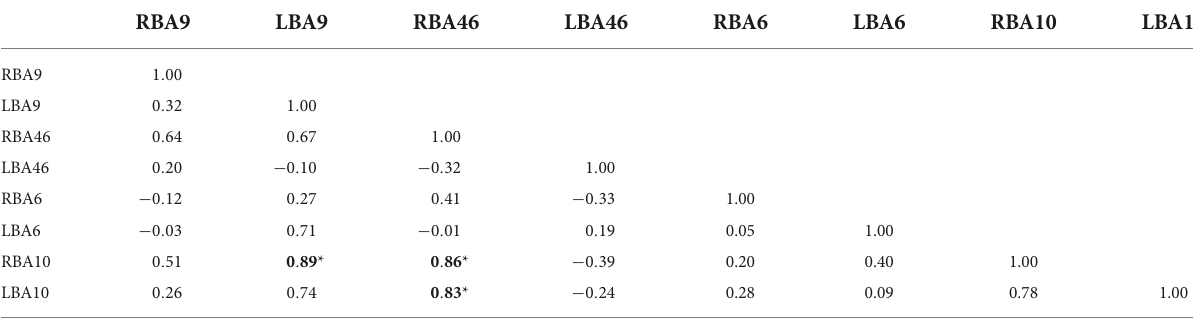
TABLE 6 HbO-based ROIs connectivity analysis—the control